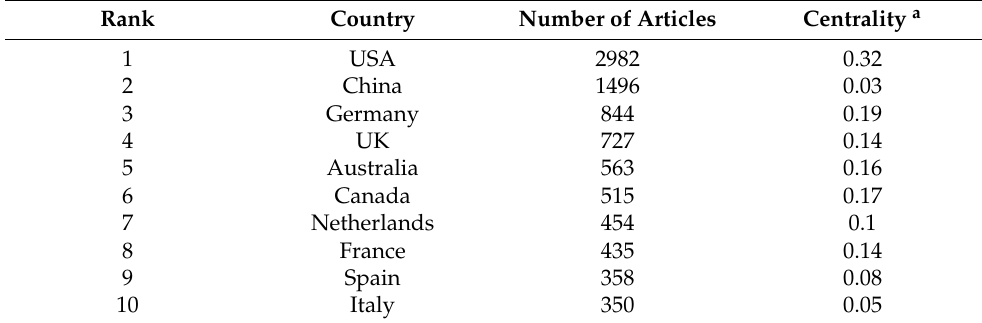
Table 1. Major countries publishing articles concerning LUT.